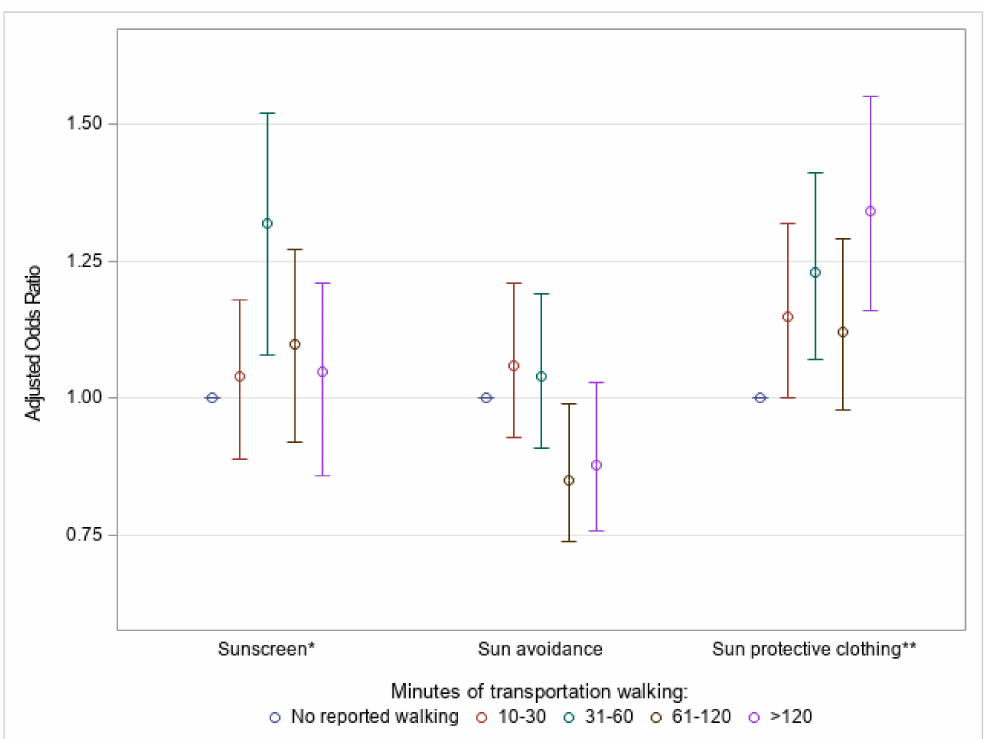
Figure 3. Weighted a adjusted b odds ratios for sun protective behaviors c by quartile of weekly transportation walking minutes for U.S. adults aged ≥ 18 years, National Health Interview Survey, 2015. (* p = 0.02; ** p = 0.0002. a 95% confidence interval; reference: No reported walking ( < 10 min of weekly transportation walking). b Covariates: Gender, age, ethnicity, education, marital status, foreign-born status, needs walking assistance, U.S. Census region, obesity or overweight, physical activity level, smoking status, binge drinking, tanning bed use, ever had a skin exam, ever had cancer, family history of melanoma, personal history of melanoma, sunless tanning product use, sunburn previous 12 months, skin reaction to sun after two weeks, and health insurance status. c Response of always or usually using SPF 15 + on a warm sunny day (sunscreen); always or usually staying in the shade or responding not going into the sun for any sun protective question (sun avoidance); always or usually wearing long sleeve shirt, long clothing to the ankles, or a wide-brimmed hat on a warm sunny day (sun protective